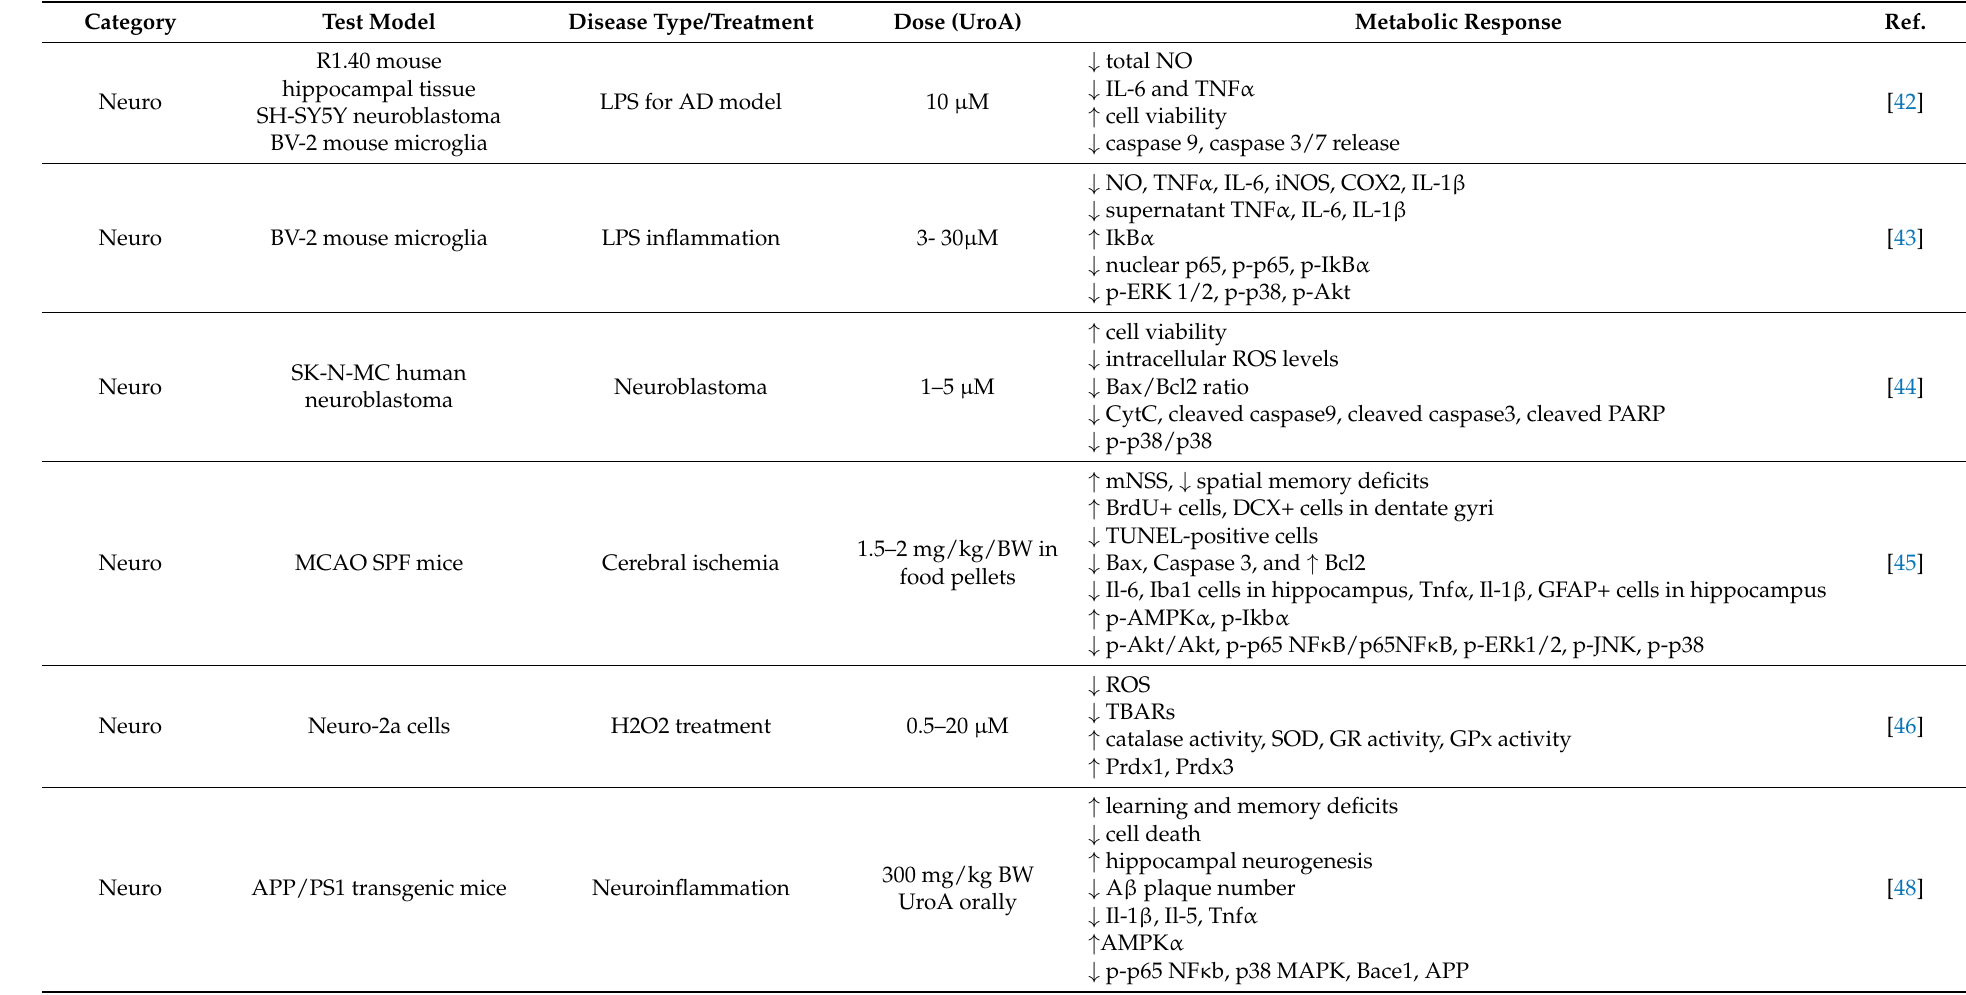
Table 2. Metabolic function of